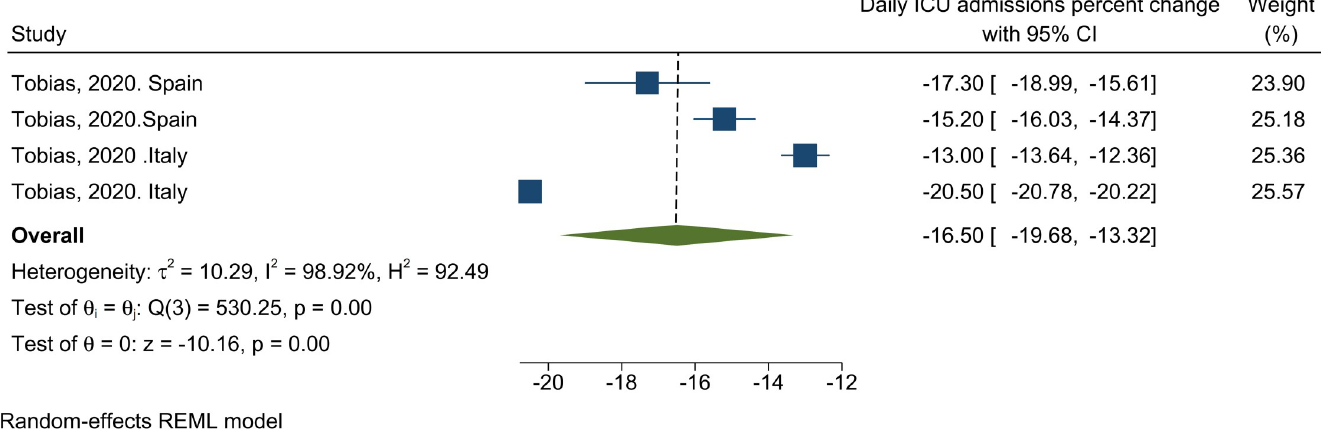
Fig 5. Results of the meta-analysis of the effects of NPHIs on the percentage of the changes in Covid-19 ICU admission in communities based on a random effect model.